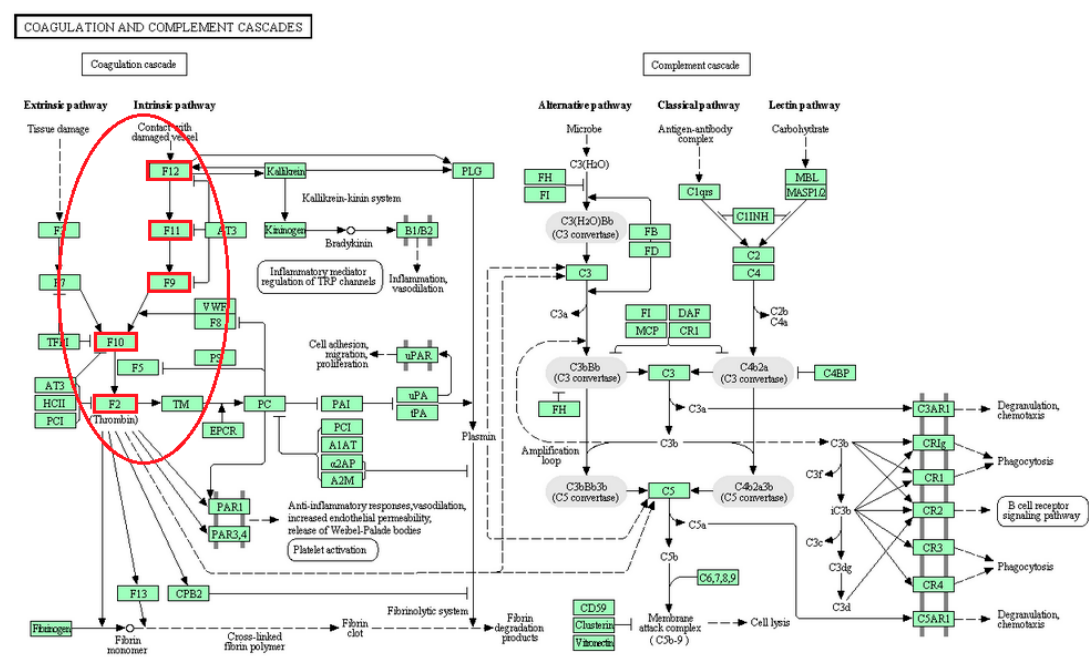
Figure 1. Snapshot of KEGG pathway map (04610) “Coagulation and complement cascades” with the detected by PerSubs subpathway highlighted in red.